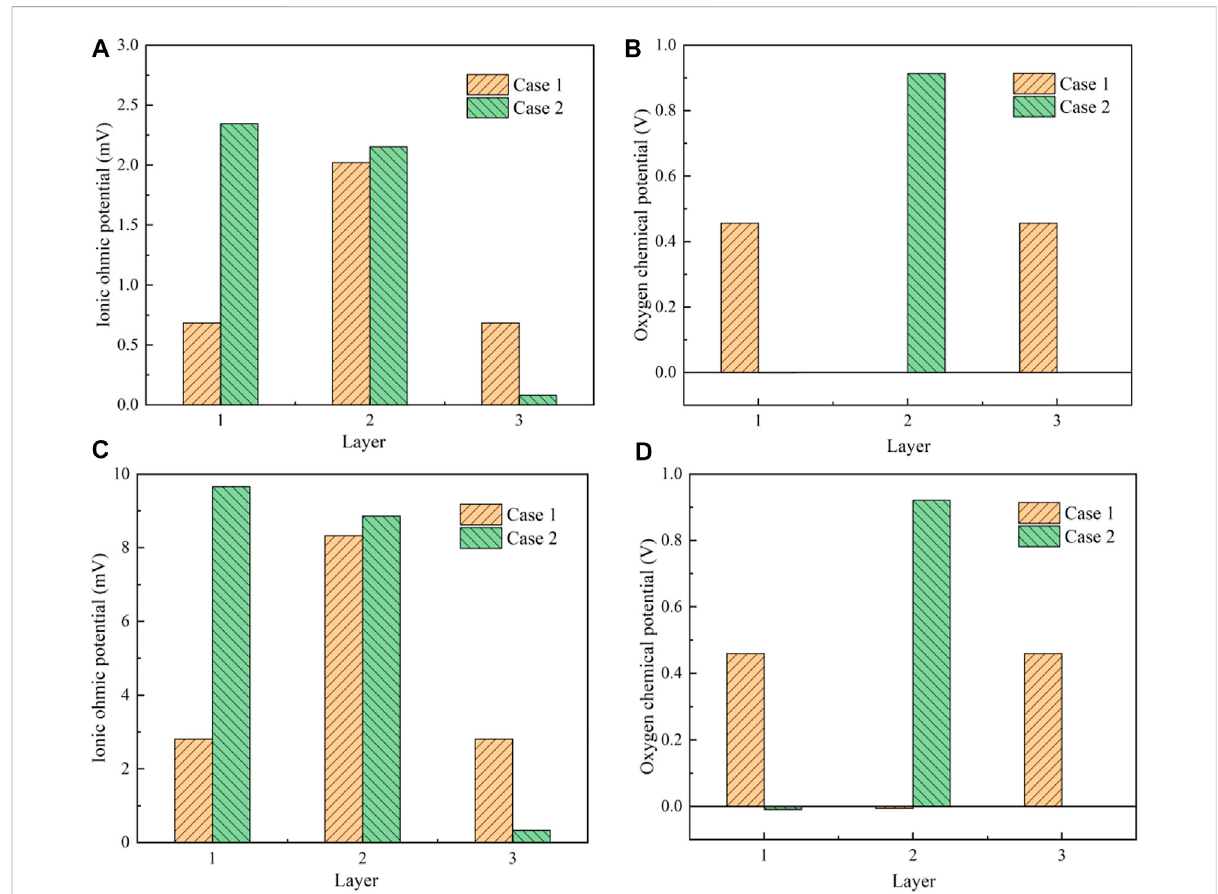
FIGURE 11 Results of the potentials inside the multilayer electrolytes: (A) oxygen ohmic potential under the current density of 0.17A/cm 2 ; (B) oxygen chemical potential under the current density of 0.17A/cm 2 ; (C) oxygen ohmic potential under the current density of 0.7A/cm 2 ; (D) oxygen chemical potential under the current density of 0.7A/cm 2